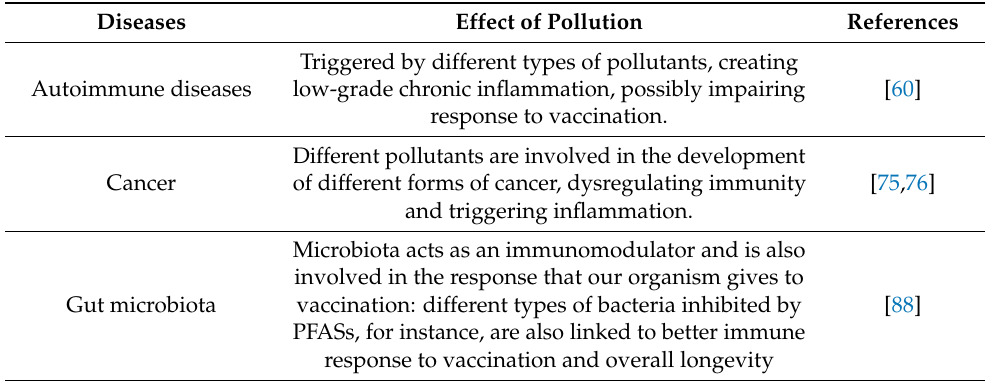
Table 2. Effects of pollution on health and